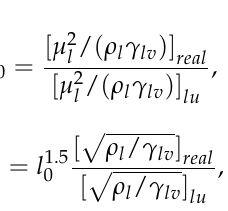
Figure 1. ( a ) Validation of the Laplace law; ( b ) variation of the normalized bridge width with time. In order to match the results with the actual situation, the lattice units are converted into physical units. The length scale is based on the consistency of the Ohnesorge number √ ρ l γ lv r , which represents the relationship between viscous force, inertial Oh = µ l / force and surface tension, and the time scale is on the basis of the merging time scale (cid:112) t i ≈ ρ l r 3 / γ lv . Then the length scale and the time scale can be derived as